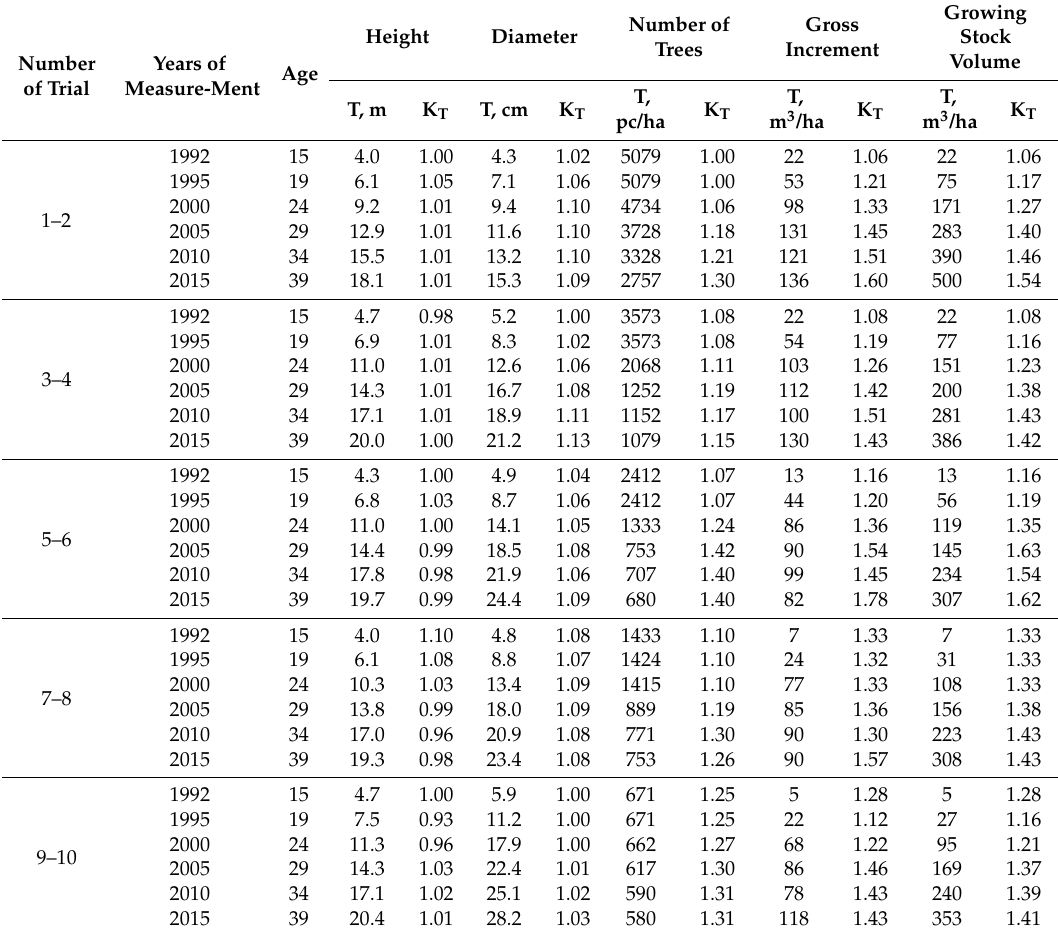
Table 4. The mean characteristics (T) of trees growing on inner rows (2, 3) and ratio of characteristics (K T ) of trees growing on outer (1) and inner (2, 3)